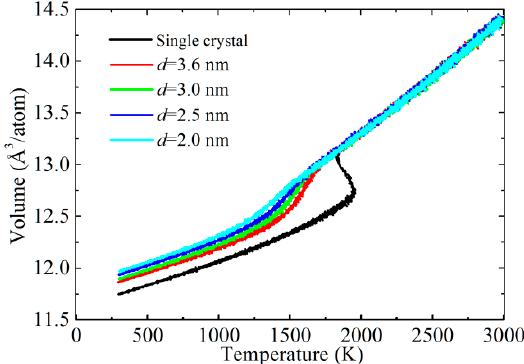
Figure 1. Volume as a function of temperature for CoCrFeNiMn high-entropy alloy with different grain sizes.